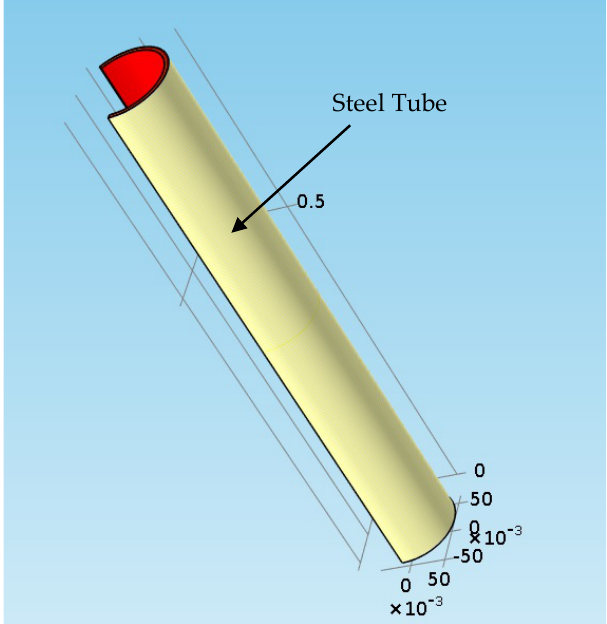
Figure 16. Three dimensional plot of the stainless steel tube.